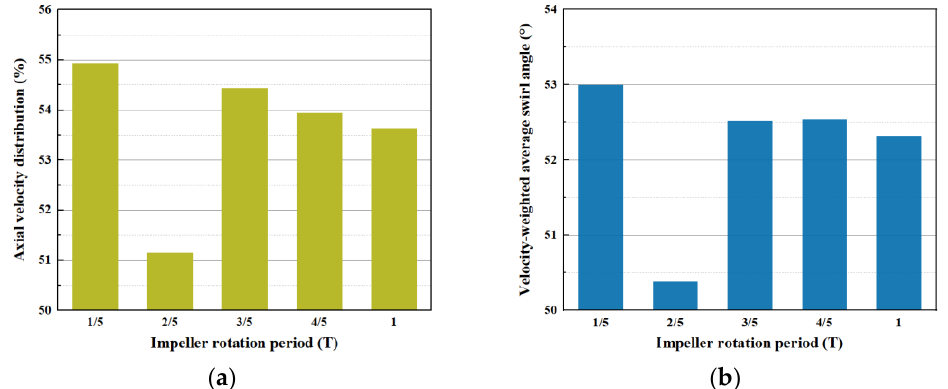
Figure 21. Axial velocity distribution and velocity weighted average angle at bell mouth at different times. ( a ) Axial velocity distribution , ( b ) Velocity weighted average angle .